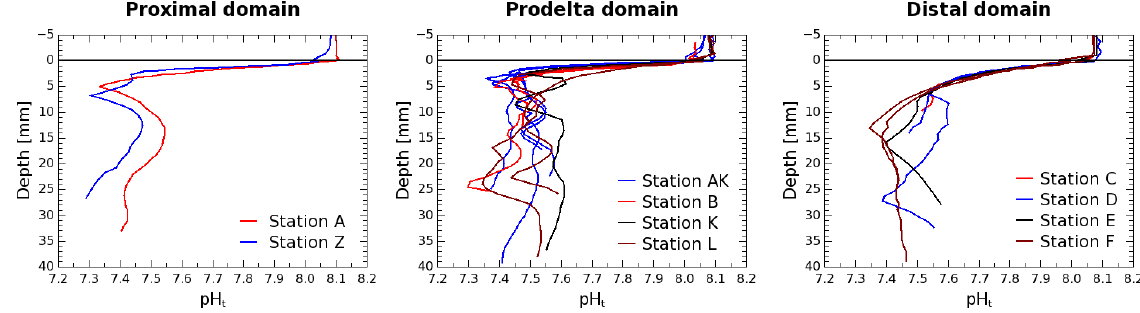
Figure 4. All pH t micro profiles measured during the DICASE cruise in the proximal, prodelta and distal domains. The sediment–water interface is marked by a horizontal line.